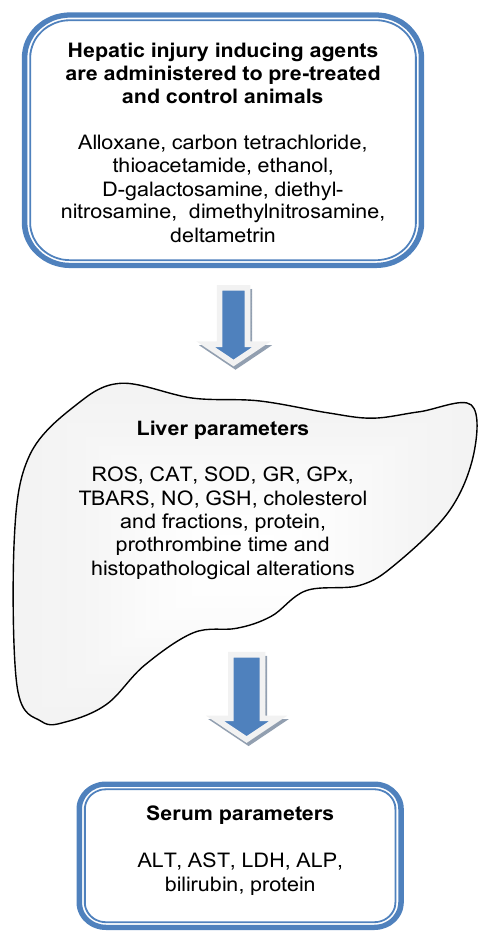
Figure 1. General scheme used for the evaluation of hepato-protective effects of crude or semi-purified extracts and isolated molecules. Animals are treated for a specific period with a probable hepato-protective agent. A lesion is induced by introducing a hepatic damage-inducing agent. Several biomarkers of hepatotoxicity are evaluated in the liver and serum of treated and non-treated animals. TBARS: thiobarbituric acid reactive